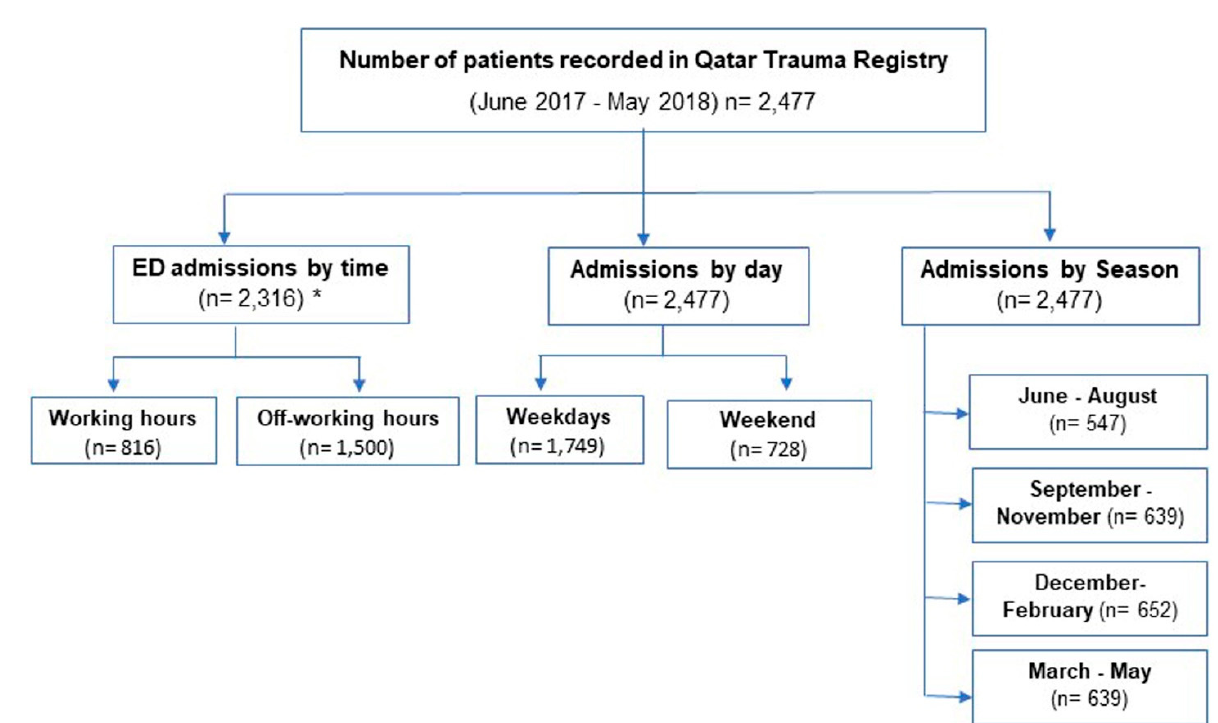
Figure 1. Study schematic (* time of ED admission was missing in 161 cases).